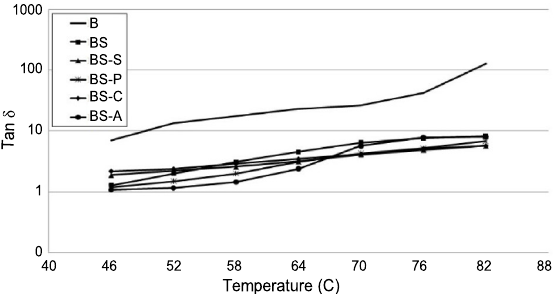
Fig. 10. Plot of G*.Sin δ for binders aged with PAV